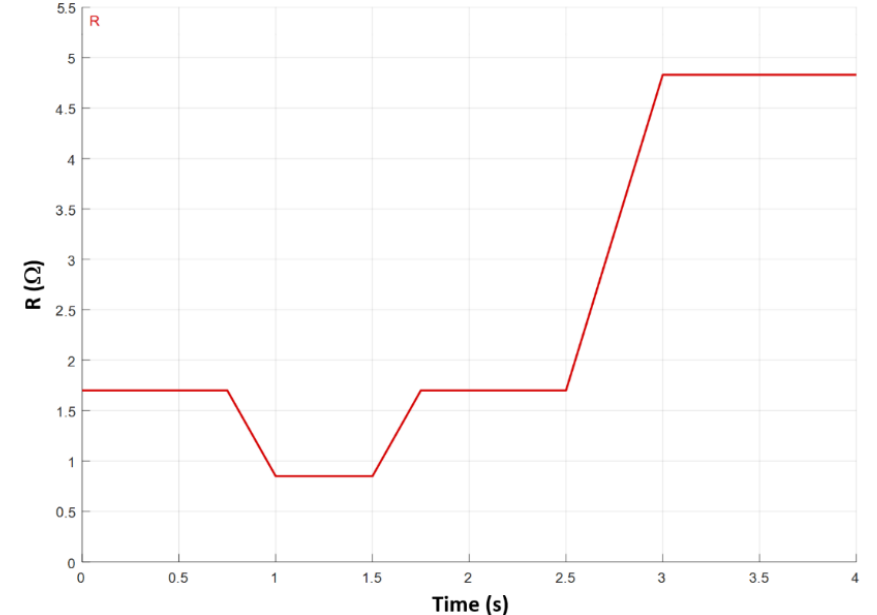
Figure 13. Load profile for the simulation.